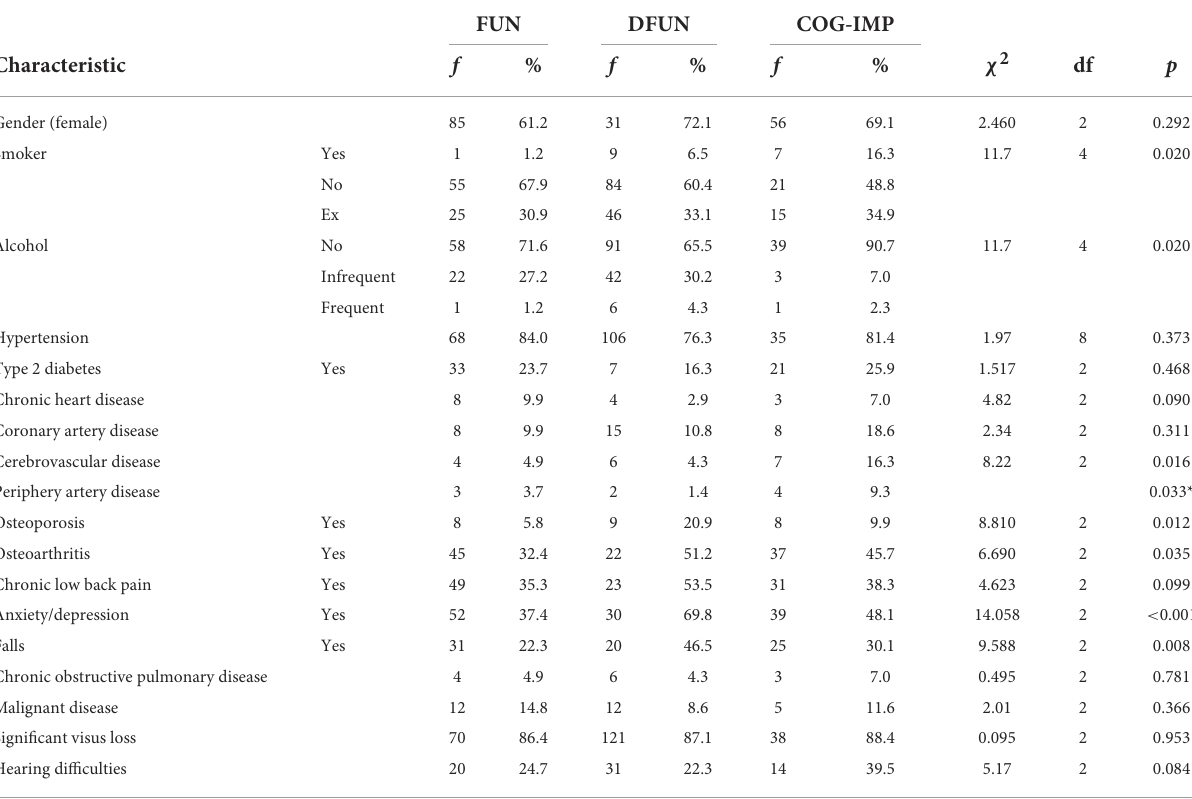
TABLE 3 Differences in frequencies of gender and some diagnoses of chronic diseases and geriatric conditions between three identified clusters. FUN DFUN COG-IMP Characteristic f